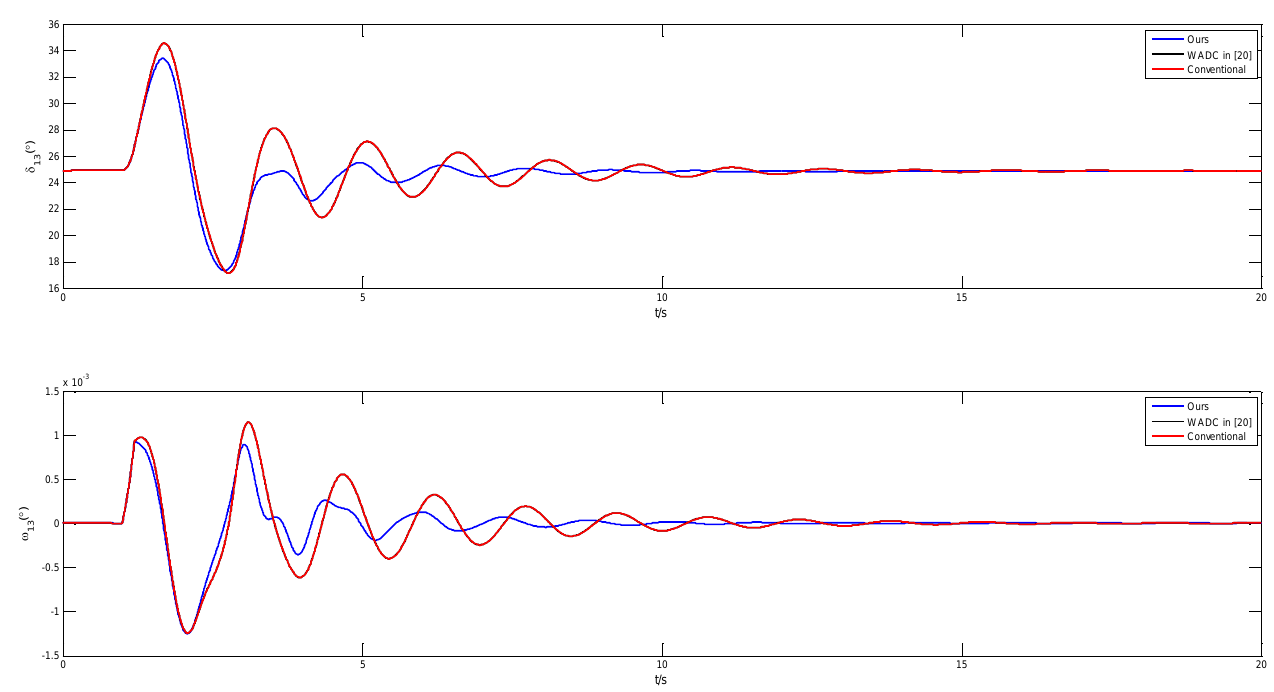
Figure 13. Response of the system in Scenario 1 when 𝜌 = 1 .